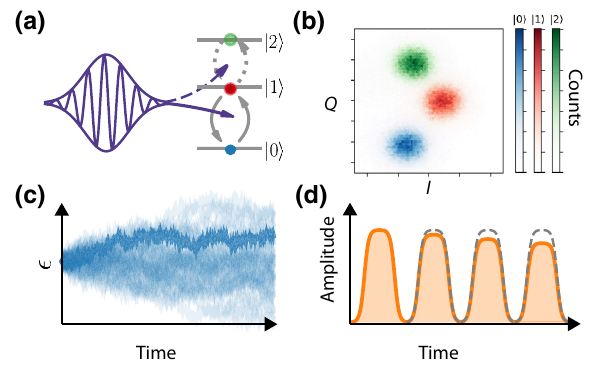
FIG. 15. Examples of errors in cQED devices that violate the typical assumptions in characterization protocols . (a) Microwave control pulses can drive transitions to the second excited state. (b) Performing a measurement can induce transi- tions to a noncomputational state. (c) Low-frequency noise on control parameters or coherence can cause fluctuations in error rates. (d) Operations can be history dependent due to, e.g.,